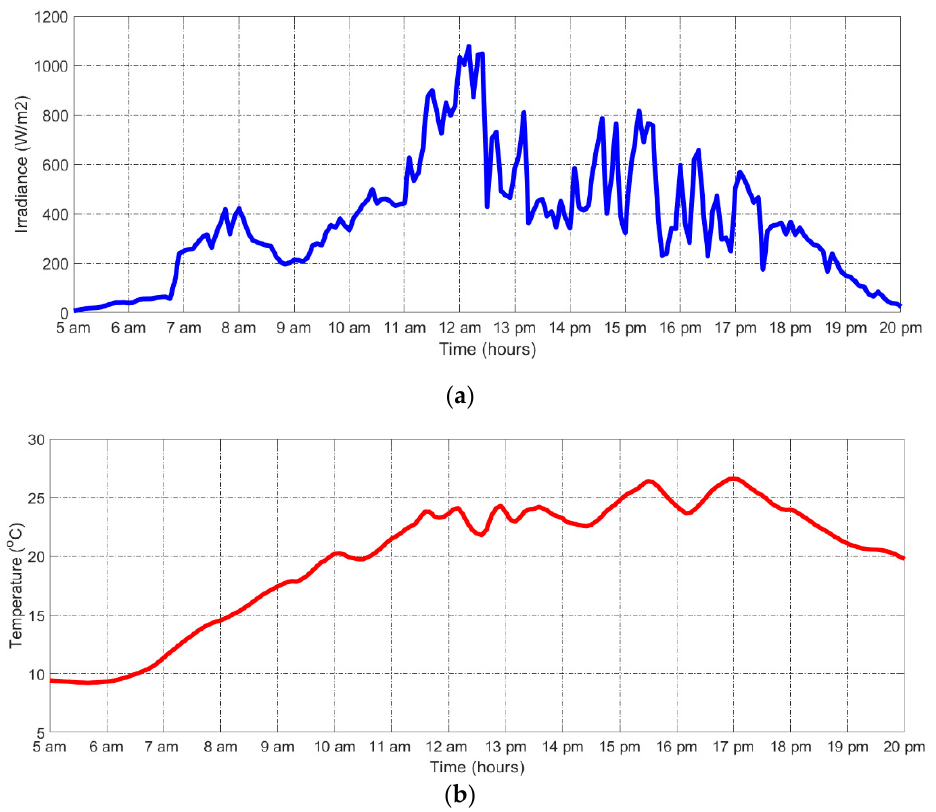
Figure 12. ( a ) Real measurement test of one day of: ( a ) Solar irradiance and ( b ) operating temperature.